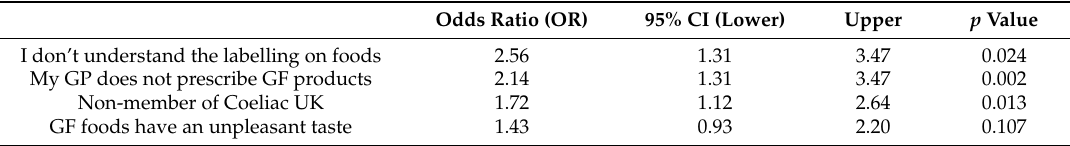
Table 4. The practicalities significantly impacting upon adhering to a gluten-free (GF) diet. Odds Ratio (OR) 95% CI (Lower) Upper p Value I don’t understand the labelling on foods